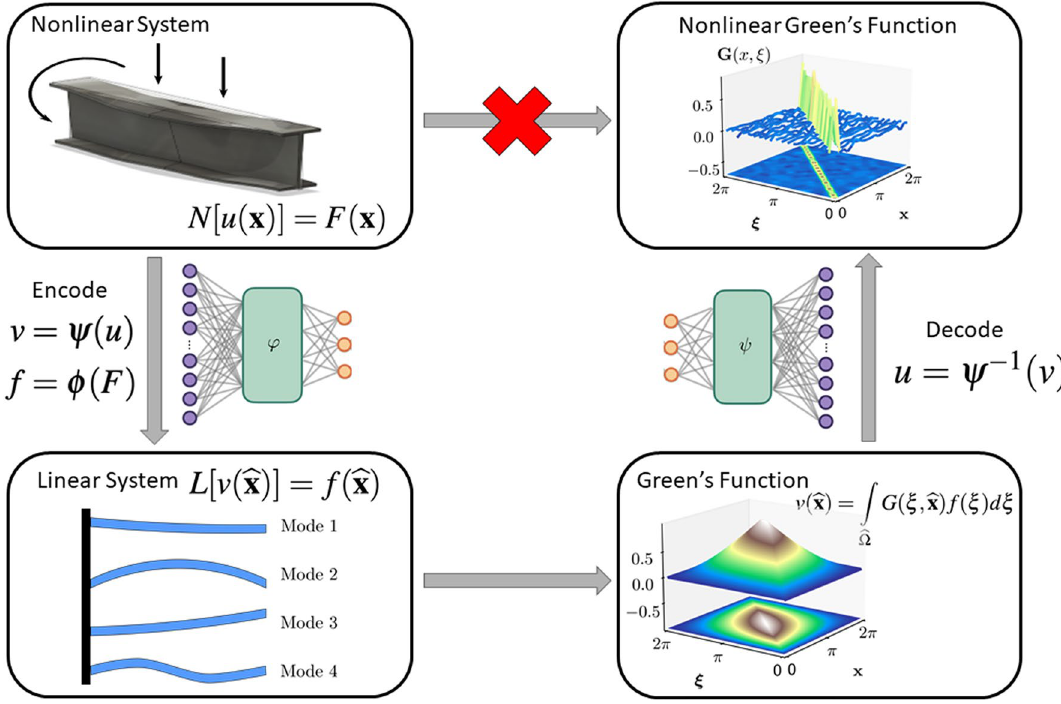
Figure 1. DeepGreen solves nonlinear BVPs by identifying the Green’s Function of the nonlinear problem using a deep learning approach with a dual autoencoder architecture. A nonhomogenous linear BVP can be solved using the Green’s function approach, but a nonlinear BVP cannot. DeepGreen transforms a nonlinear BVP to a linear BVP, solves the linearized BVP, and then inverse transforms the linear solution to solve the nonlinear